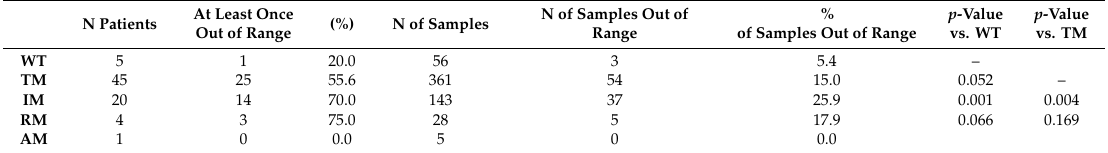
Table 2. Out of range tacrolimus blood levels stratified by group of gene mutation.